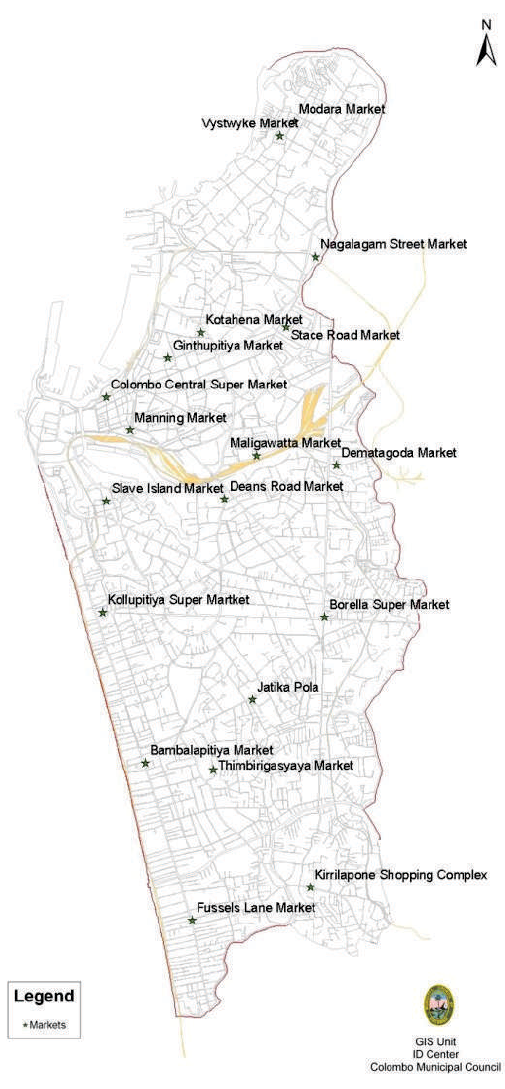
Figure 4: Distribution of major markets in Colombo Municipality